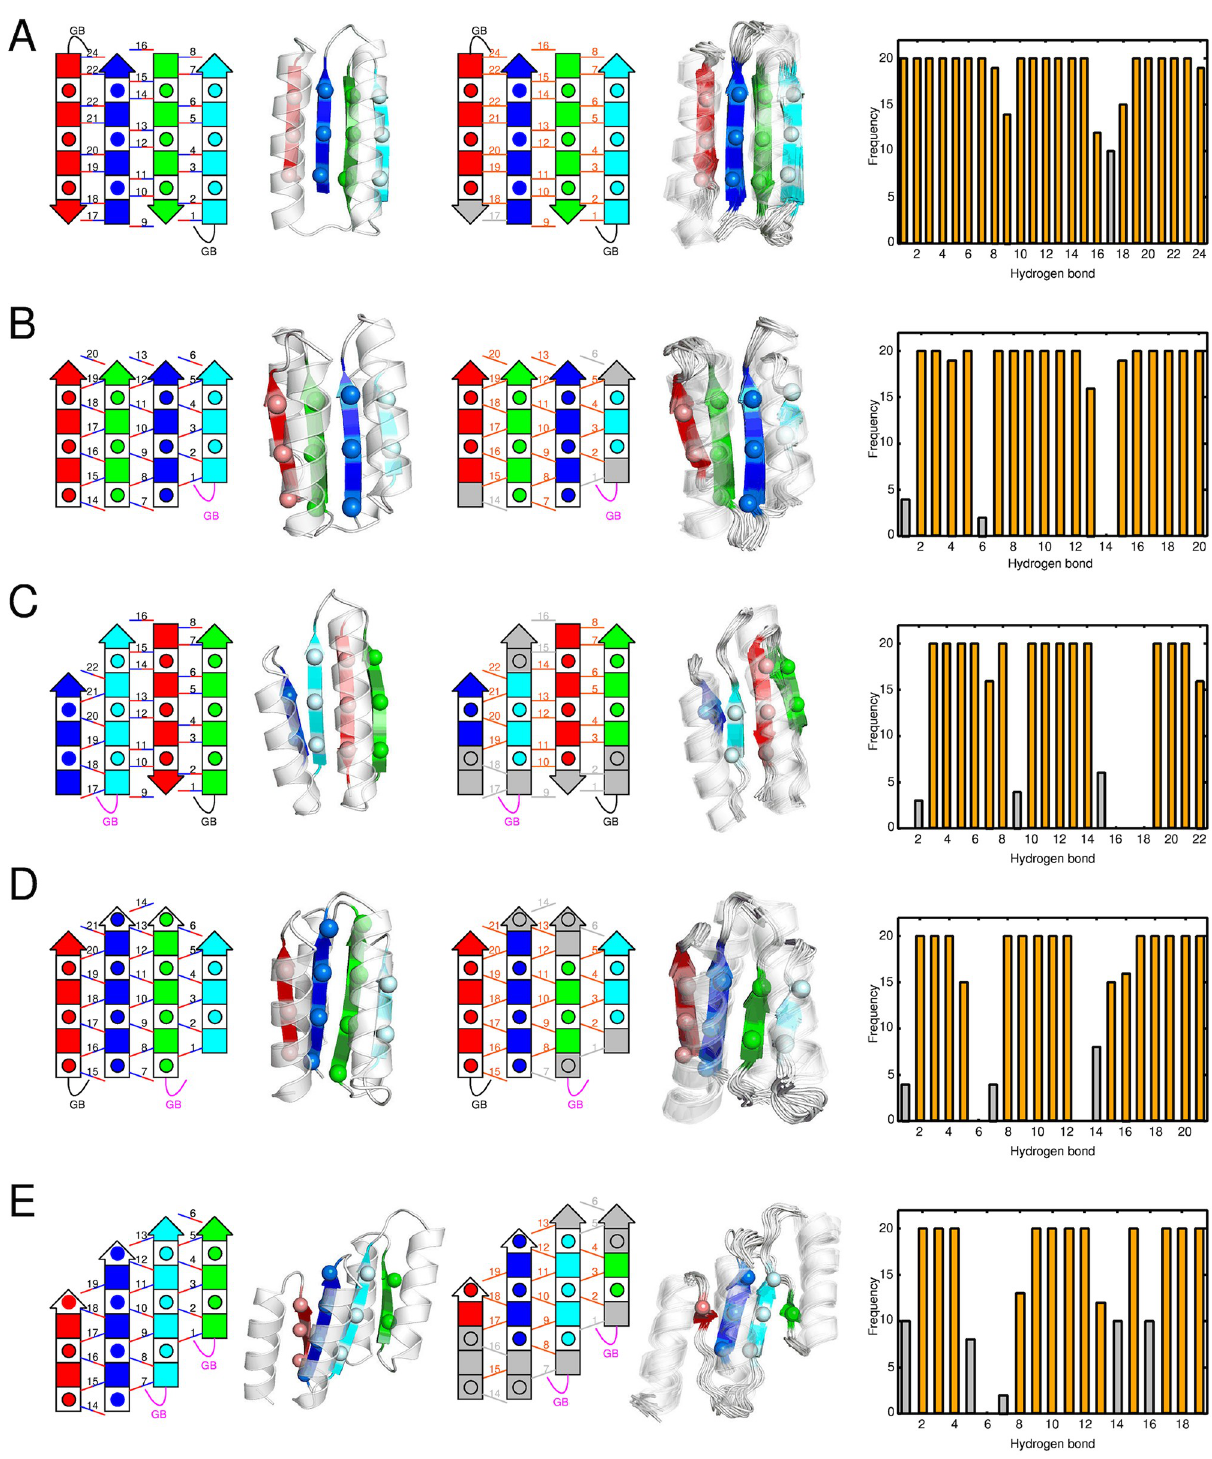
Fig 9. The degree of agreement between the blueprints and the NMR structures for the five de novo -designed proteins reported in Ref. [3]. Left to right: the blueprints, the target structures, the blueprints colored according to their consistency with their NMR structures, the NMR structures, and frequency of the hydrogen bonds formation in the NMR structures. On the rightmost column, hydrogen bonds with a forming probability of 50% or less are indicated by gray bars, and the others are indicated by orange bars. Correspondingly, on the third column from the left, hydrogen bonds with a forming probability of 50% or less are indicated by gray lines, the other hydrogen bonds are indicated by orange lines, and residues that were designated